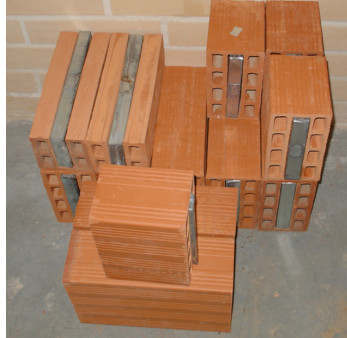
Figure 14. Clay bricks and PCM macro-capsules integration, Silva et al. [133] (reproduced with permission from Elsevier).